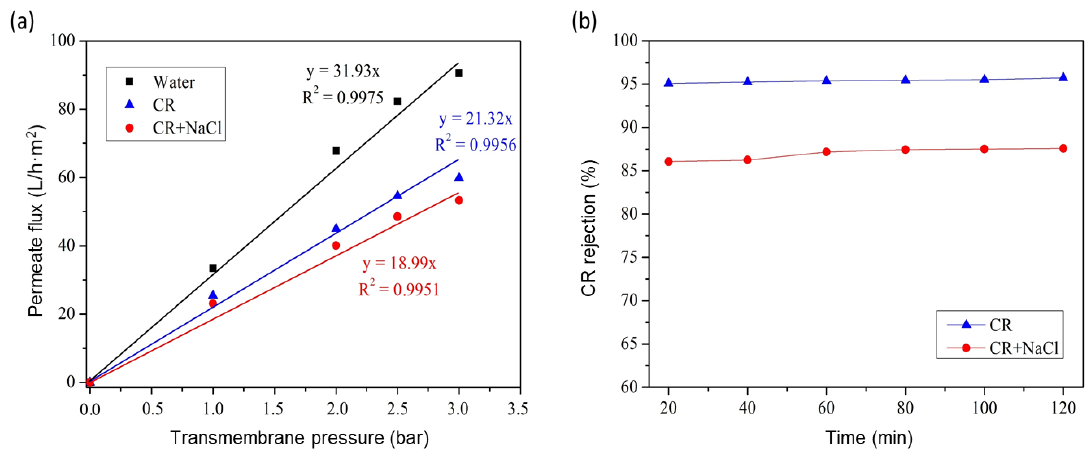
Figure 14. ( a ) Variation of the water permeate flux; ( b ) rejection rate of the pure CR dye and CR- NaCl mixture.